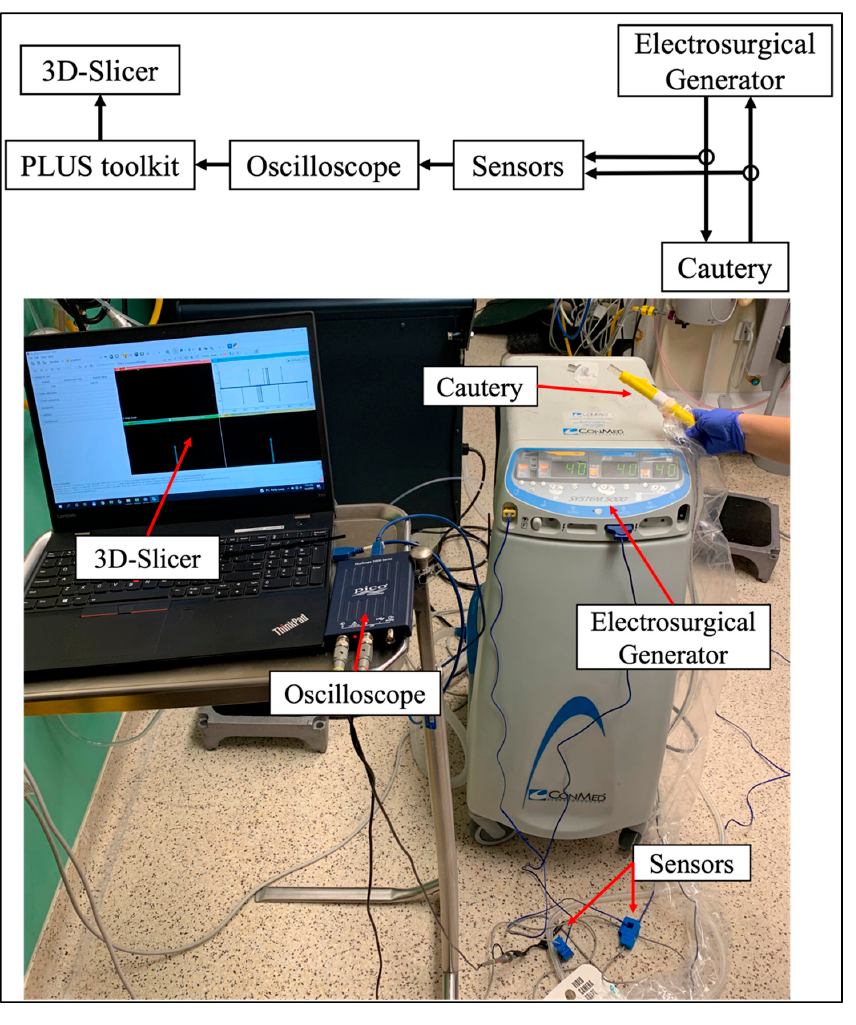
Figure 1. Schematic of the experimental set-up for automated, sensor-driven data collection on electrocautery status ( top ) and experimental set-up in the operating room for ex viva data collection sessions ( bottom ).